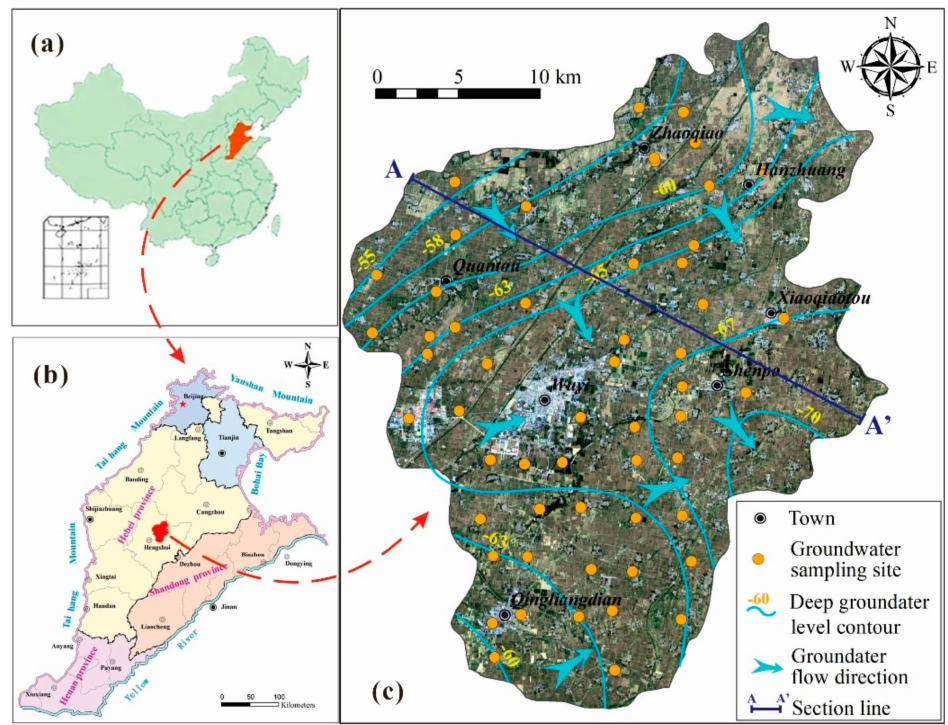
Figure 1. Location of ( a ) the North China Plain, ( b ) the study area and ( c ) groundwater sampling